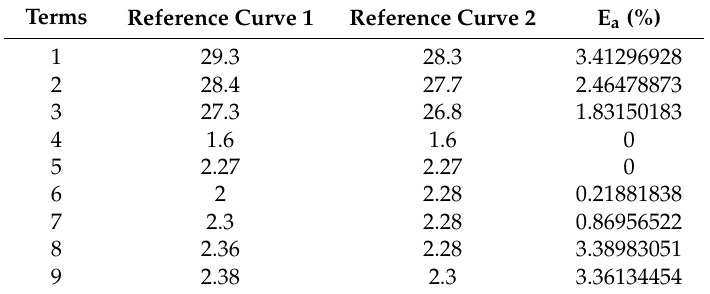
Table 2. Summary table of quantification of maximum percentage errors regarding the PV system.